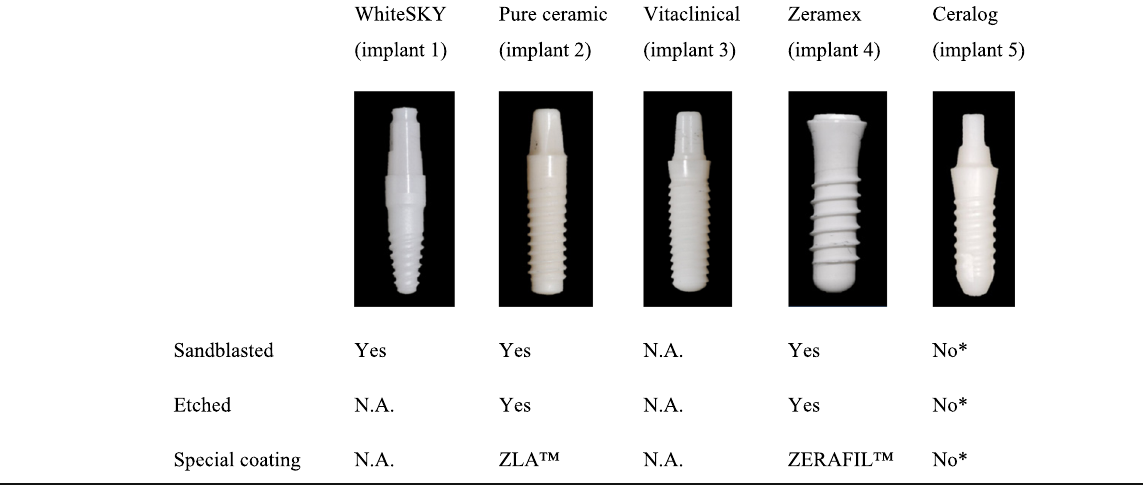
*Due to the processes CIM and HIP, see the “ Methods ”